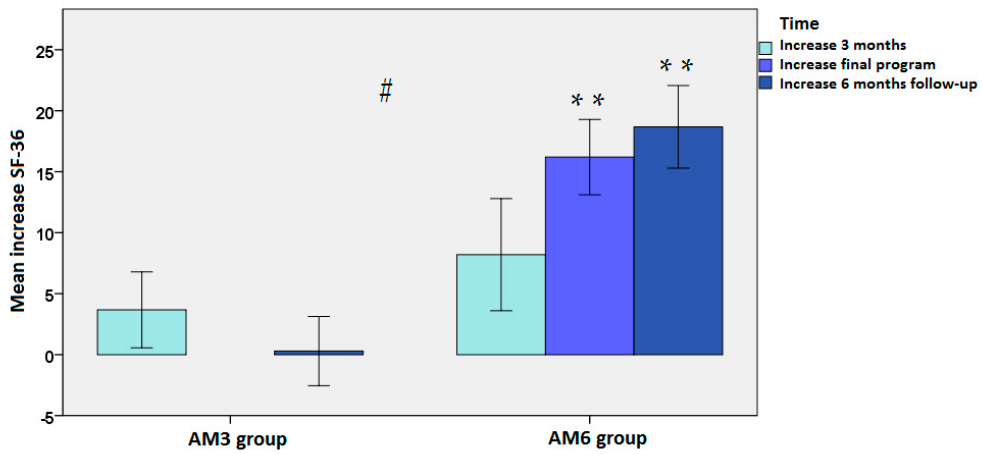
Figure 3. Mean changes in the subscale of energy/vitality in the ACTIVA Murcia (AM) exercise programs of 3 months (AM 3 ) and 6 months (AM 6 ): ** p < 0.001 as compared with the baseline using ANOVA for repeated measures with one study factor (time); post hoc analyses were performed with the Bonferroni’s correction; # p = 0.05 at 6 months of follow-up of the AM 3 vs. AM 6 using ANCOVA: dependent variable (physical functioning at 6 months follow-up); fixed factors (program and sex); covariates (baseline values and